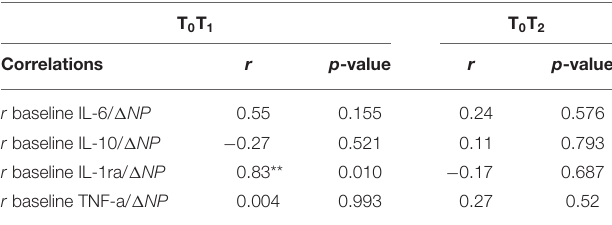
Frontiers in Rehabilitation Sciences |